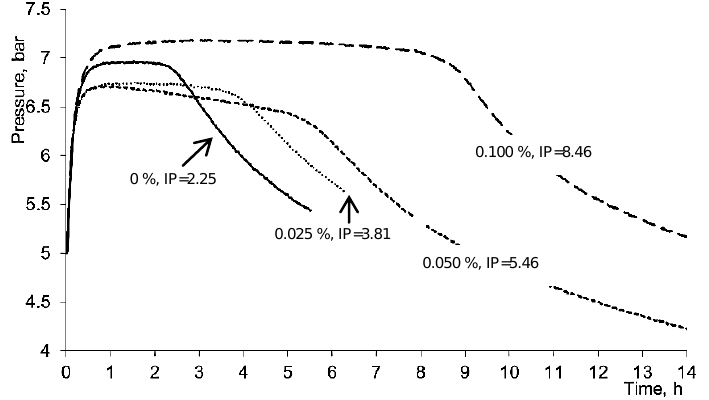
Figure 3. Effect of 5,8-DHC concentration on rapeseed oil autooxidation induction period